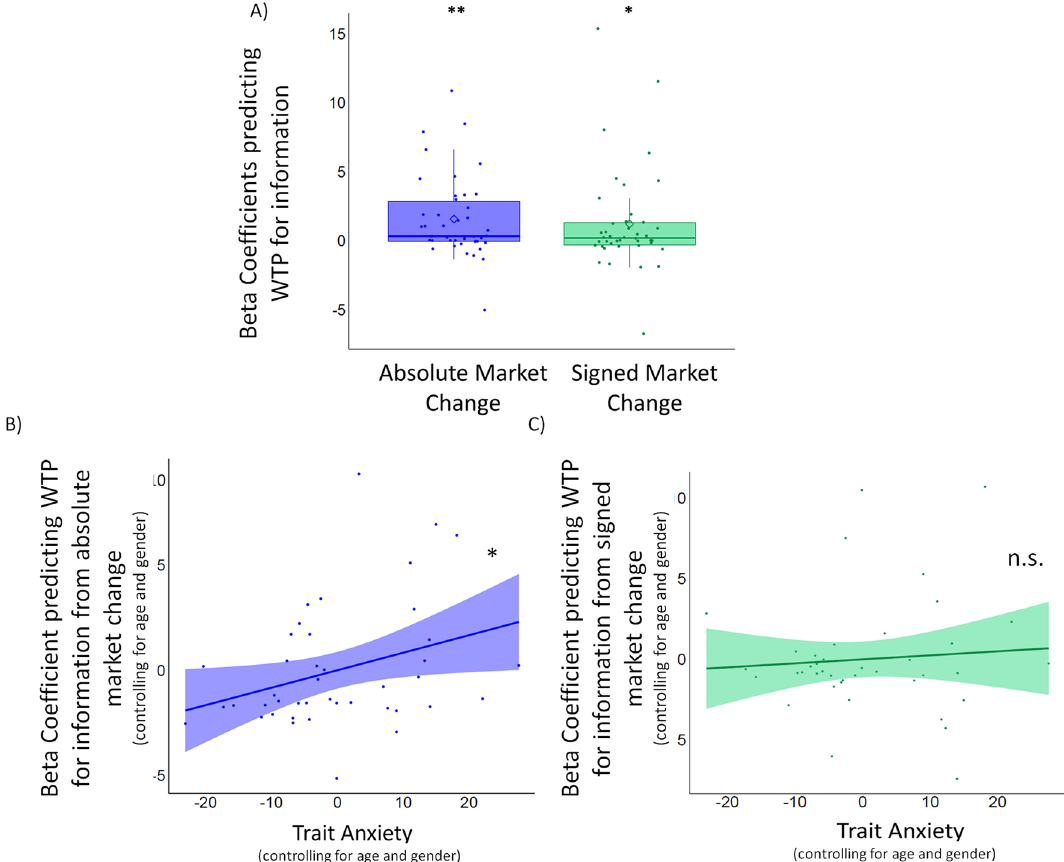
Figure 4. Trait anxiety amplifies the impact of the magnitude of change in the environment on information- seeking (Study 2a). ( A ) A linear regression was conducted for each participant to predict WTP from the signed market change and absolute market change and the resulting betas were then compared to zero with a one- sample t-test. Both signed market change (signaling whether the market was going up or down) and absolute market change (signaling the magnitude of changes in the market) predicted participants’ willingness to pay for information. Specifically, participants’ willingness to pay for information was greater when the market was going up rather than down and when there were large changes in the market. Plotted are the beta coefficients reflecting the effect of signed (green) and absolute (purple) market change on WTP. Horizontal lines indicate median values, boxes indicate 25–75% interquartile range, diamonds indicate mean values and whiskers indicate 1.5 × interquartile range; individual coefficients are shown separately as dots. **p = 0.01, *p < 0.05. ( B , C ) Increased trait anxiety was associated with greater impact of absolute market change on information- seeking (p = 0.039) ( B ) but not with changes to the impact of valence on information-seeking (p = 0.616) ( C ). ( B , C ) Plotted are the partial linear regressions predicting the beta coefficients shown in ( A ) from trait anxiety, controlling for age and gender. Also note that in panels ( B ) and ( C ) plotted values are residuals after controlling for age and gender, hence the negative trait anxiety